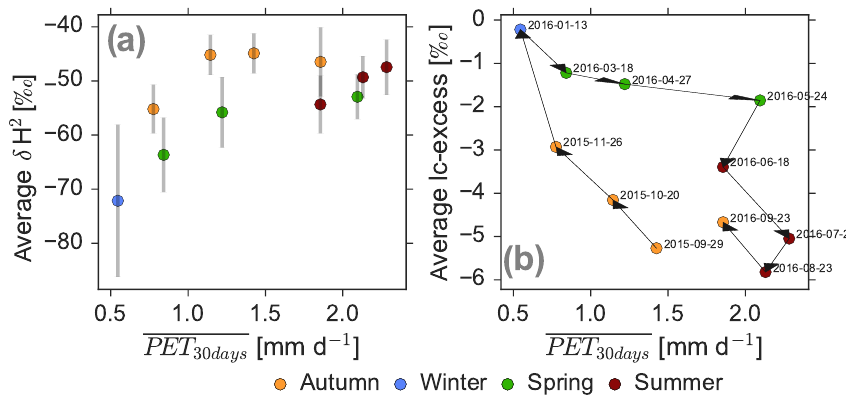
Figure 4. Variation of the (a) δ 2 H and (b) lc-excess in the top 20cm of the soil as a function of the potential evaporation averaged over the 30 days prior to the sampling day (PET 30 ) . The colors of the scatter points indicate the season of the sampling. The error bars in (a) indicate the standard deviation of δ 2 H in the soil waters. The arrows in (b) indicate the order of sampling and sampling dates are given.